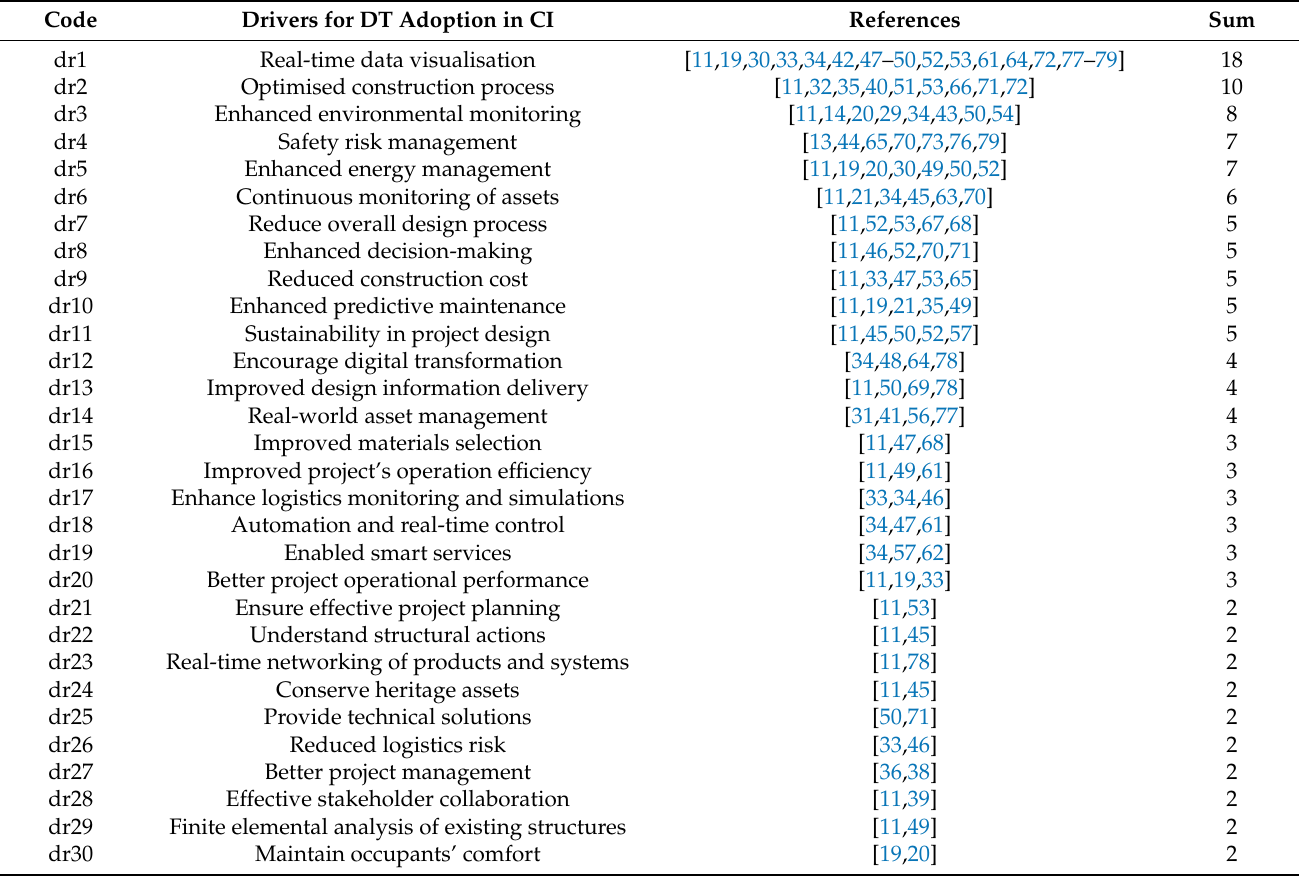
Table 3. Drivers for DT adoption in construction industry identified in the